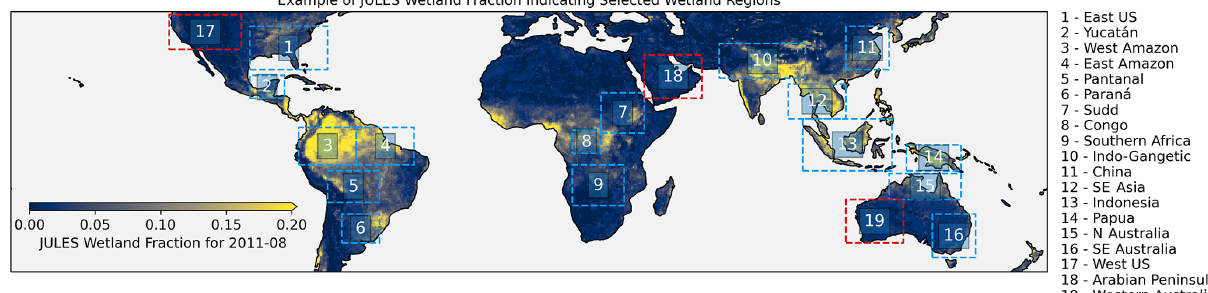
Figure B1. An adjusted version of Fig. 3 showing the locations of the 16 wetland regions considered in this study plus 3 additional non- wetland regions (in red). A representative month (August 2011) of the JULES wetland fraction is shown as the basemap.